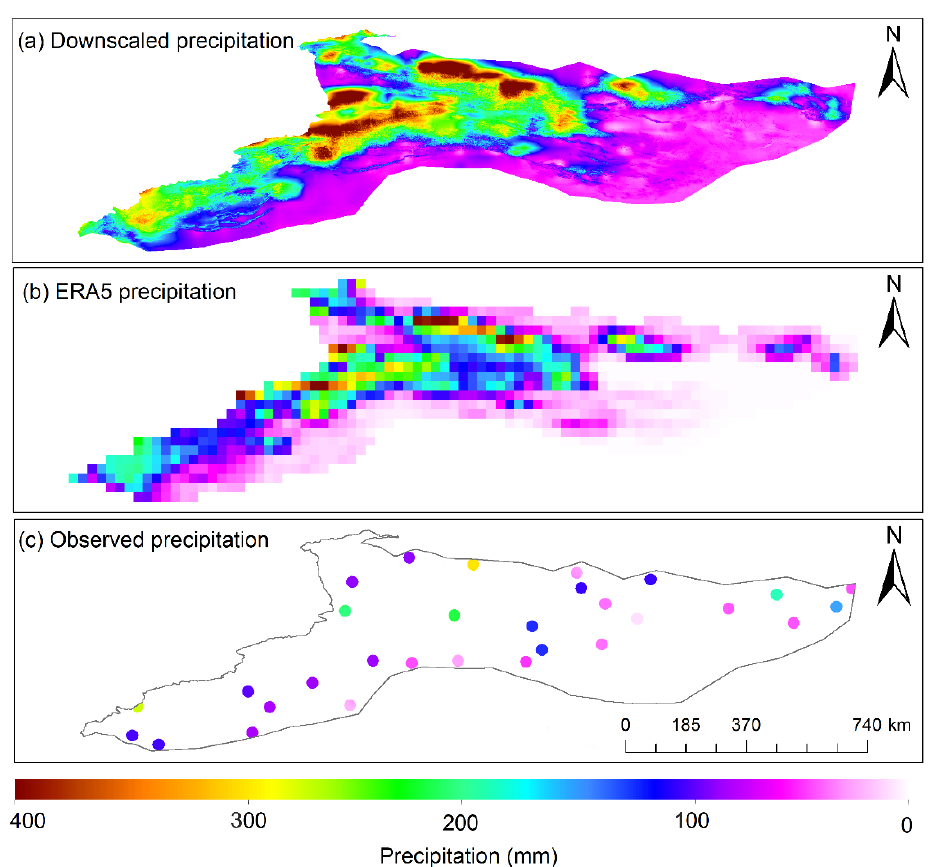
Figure 3. The comparison of downscaled dataset ( a ), ERA5 reanalysis ( b ), and observations ( c ): average precipitation in July from 1979 to 2020.